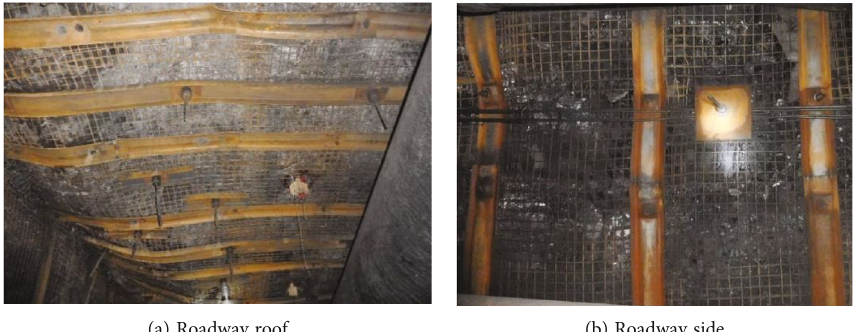
Figure 21: Schematic diagram of